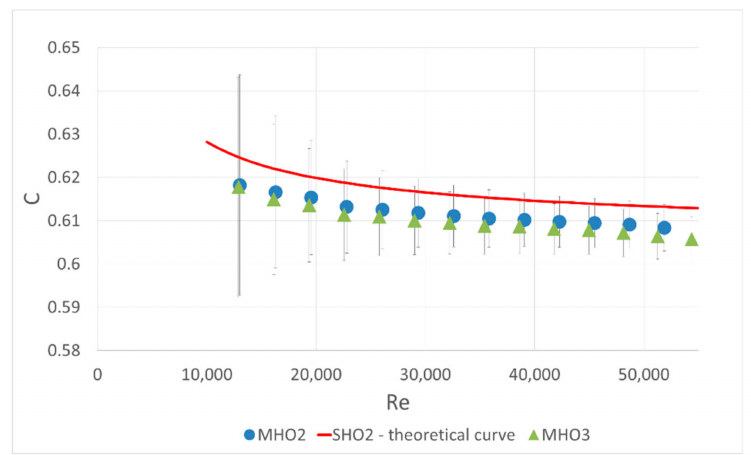
Figure 7. Experimental results for two multi-hole orifices with di ff erent chamfer angle and the same contraction coe ffi cient β =